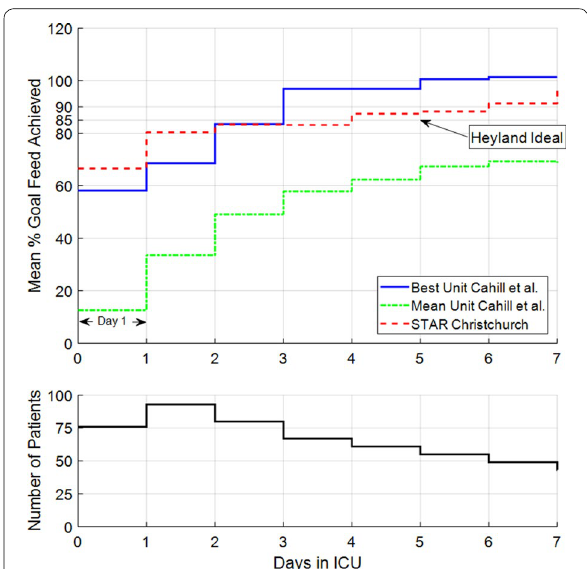
Fig. 1 (Top) Comparison of mean percentage goal feed achieved for each day in the ICU between STAR Christchurch clinical results and the results published in Cahill et al. The ‘Heyland ideal’ 85% caloric goal, to minimise mortality, presented in Heyland et al. [51] is also provided for comparison. (Bottom) The number of patients per day, where it is important to note that not all of the 221 patients start on day 1